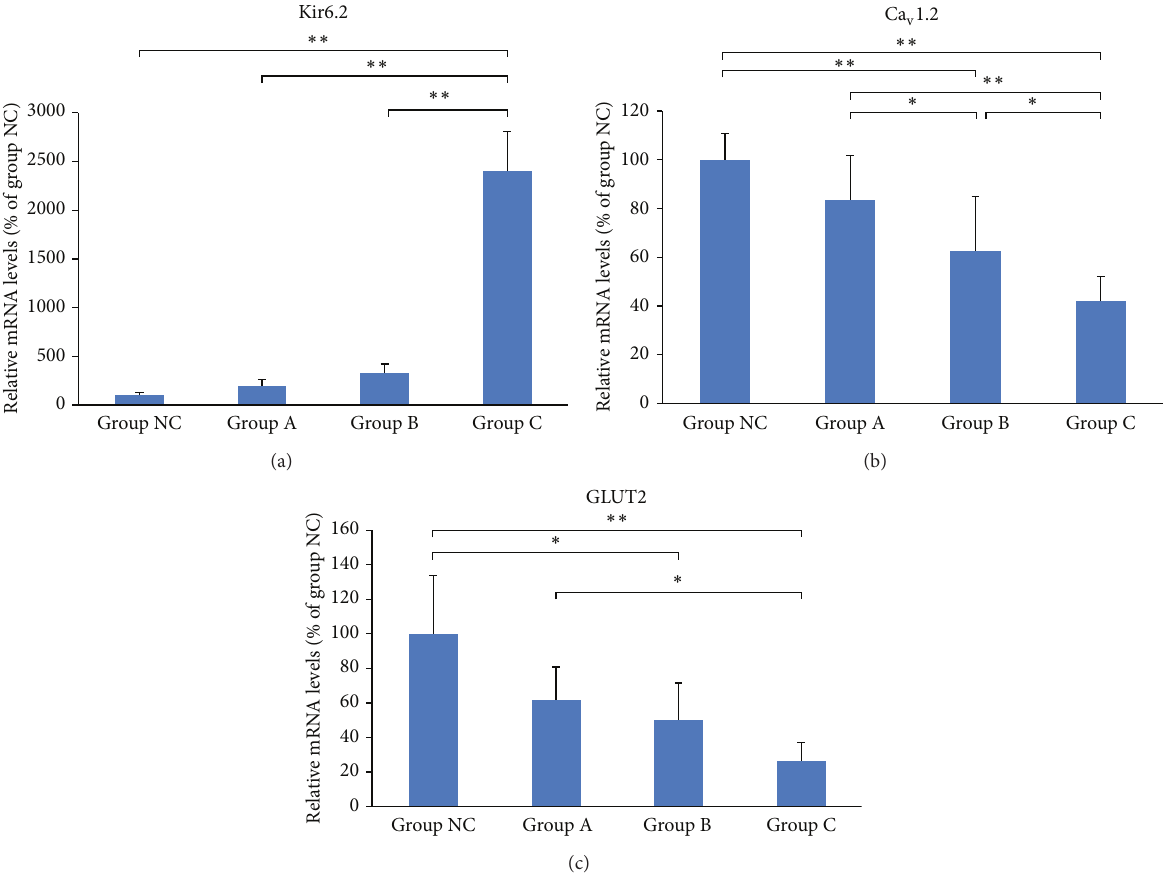
and transferred onto nitrocellulose membranes. Blots were incubated with the specific primary antibodies overnight at 4 ∘ C. After washing them three times for 15 min each with TBST (TBS + 0.1% Tween20), blots were incubated with a horseradish peroxidase-conjugated secondary antibody (Pierce, Rockford, IL, USA) and visualized by